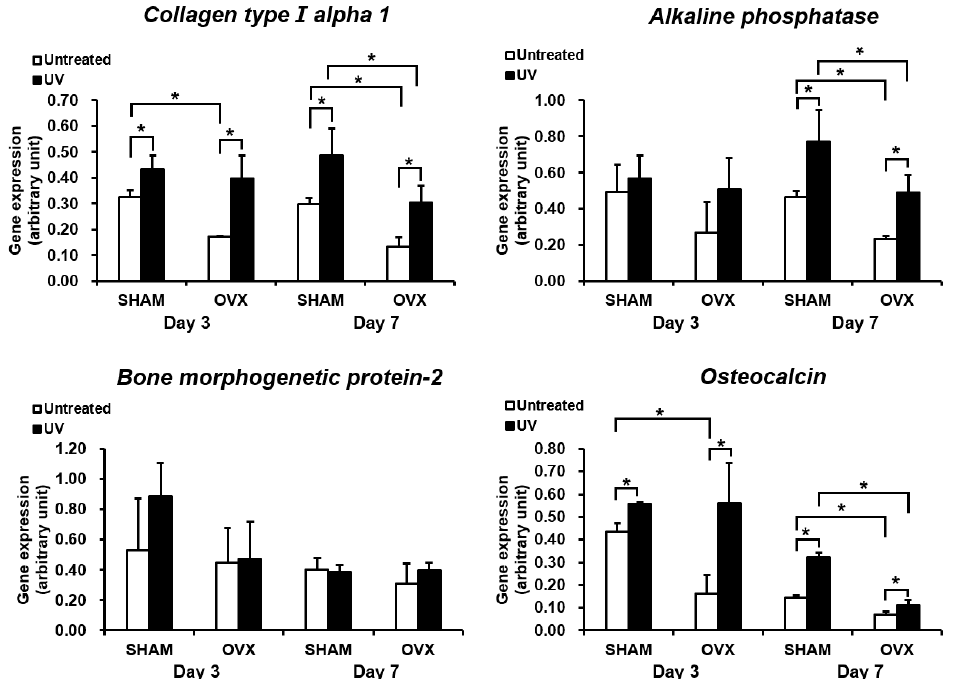
Figure 6. Gene expression levels of selected markers quantified by real-time qPCR. The osteogenic markers collagen type I alpha 1, alkaline phosphatase, bone morphogenetic protein-2, and osteocalcin were analyzed. Total RNA was isolated at 3 and 7 days from osteoblastic cell cultures on acid-etched titanium surfaces with or without UV-treatment. Relative expression levels (2 −ΔΔ Ct values) of the genes of interest were normalized to that of the housekeeping gene Gapdh . Each value represents the mean ± standard deviation of triplicate experiments ( n = 3). * p < 0.05, significant difference between untreated and UV light-treated surfaces.